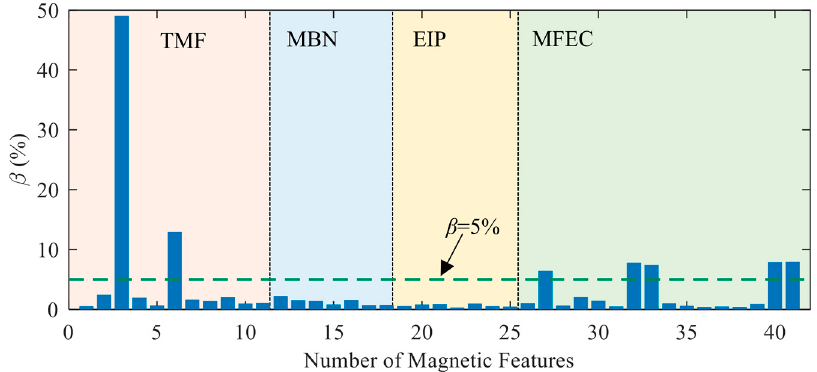
Figure 6. Estimated coefficients of variations of the magnetic features under dynamic conditions.